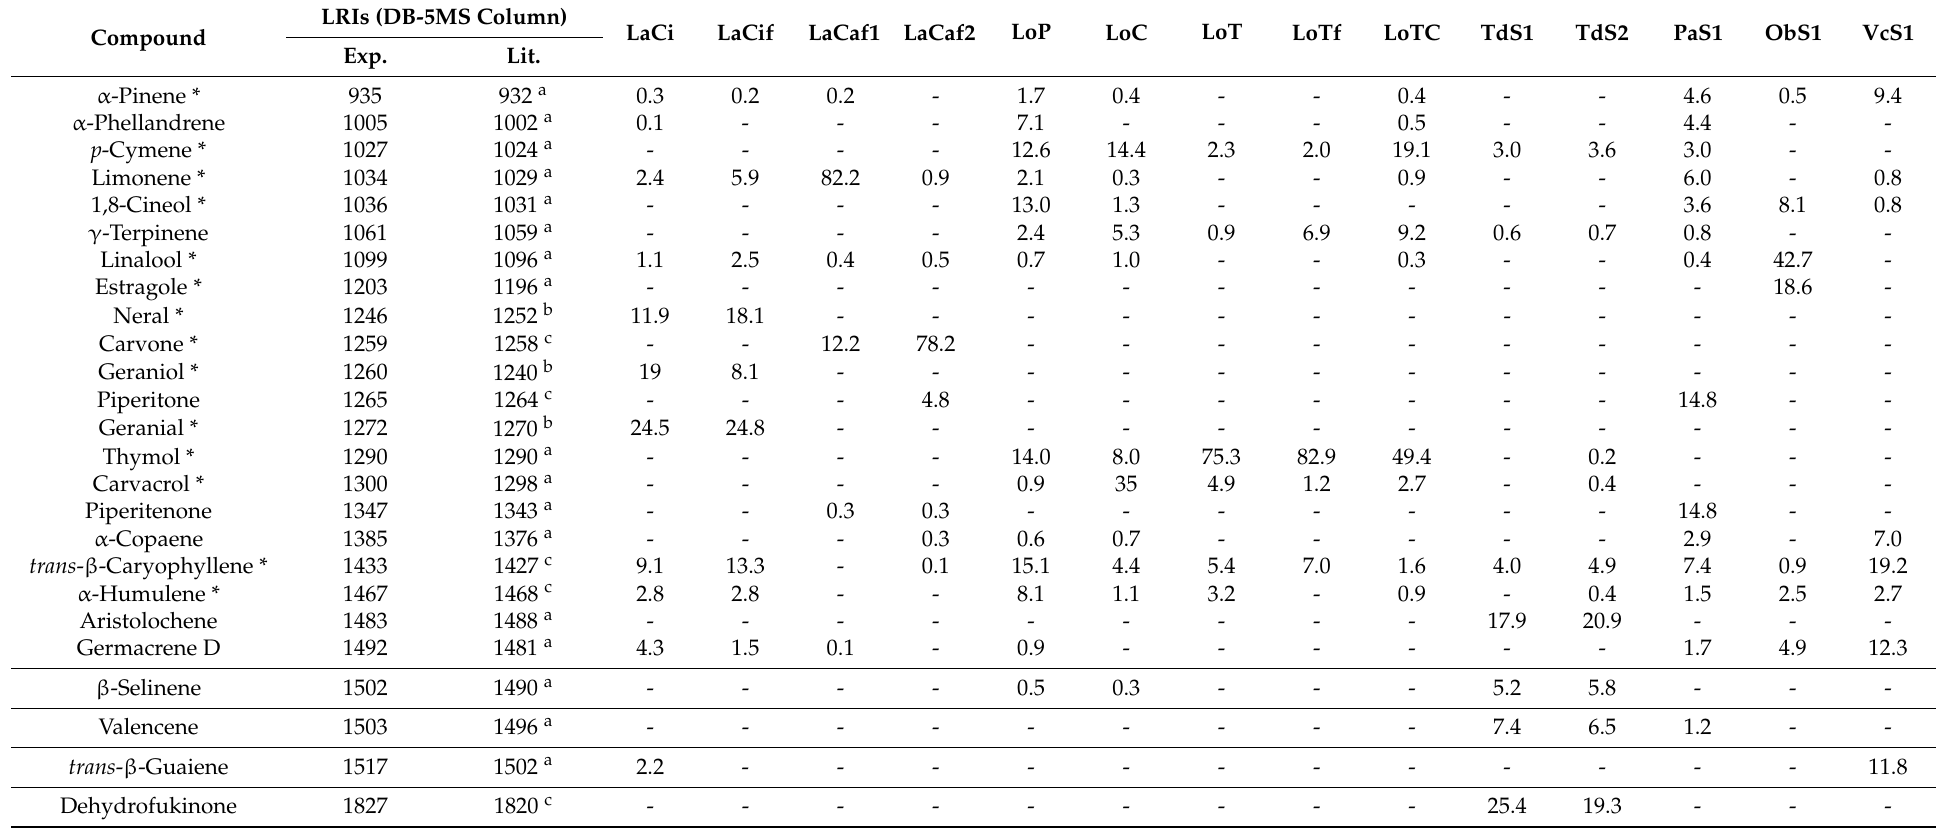
Table 2. The main chemical constituents of essential oils or their fractions studied in this